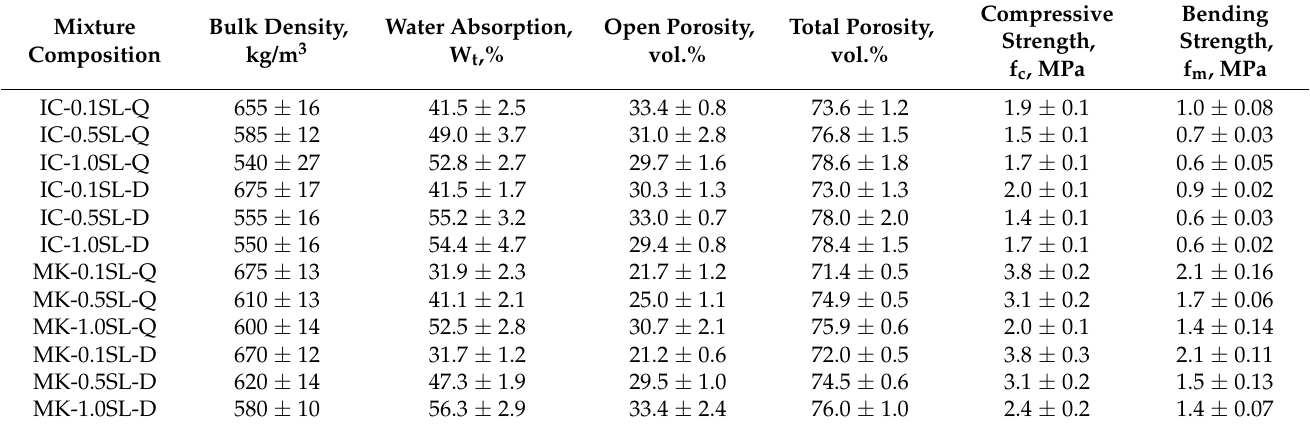
Table 3. Physical and mechanical properties of porous geopolymers.